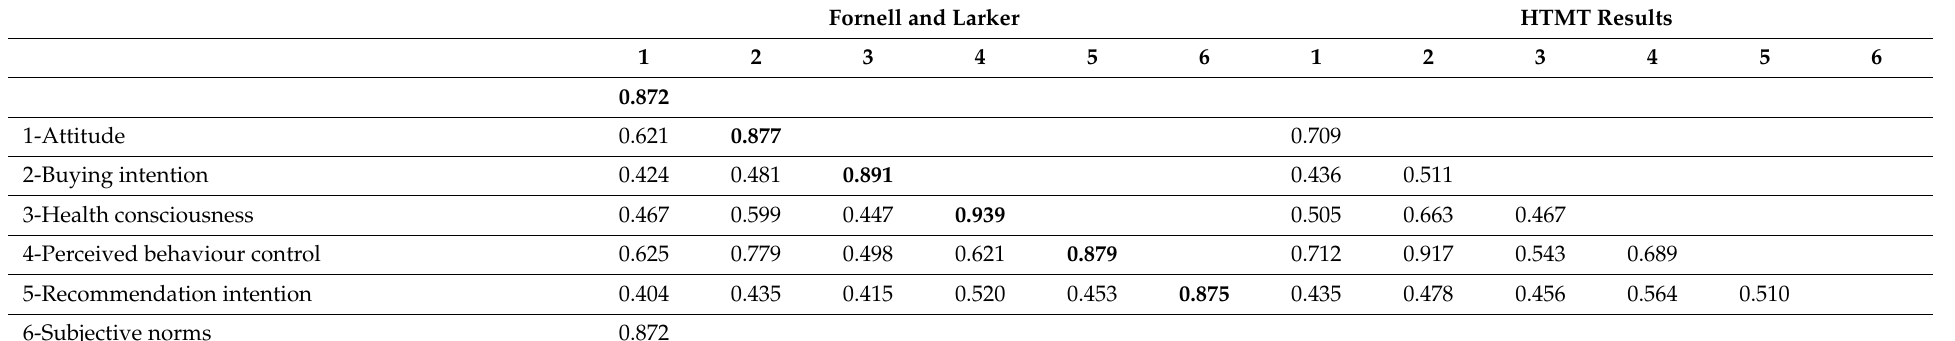
Table 3. Discriminant validity (UK data set).